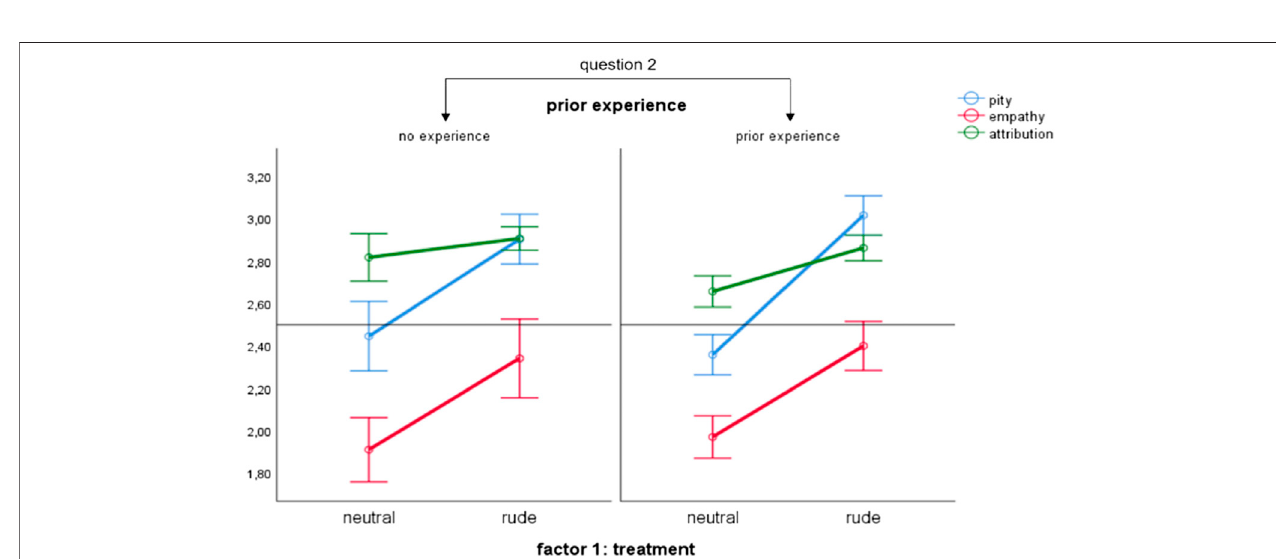
FIGURE 6 | Effects of treatment and participant ’ s prior experience on empathy with the CA (controlled for trait empathy).